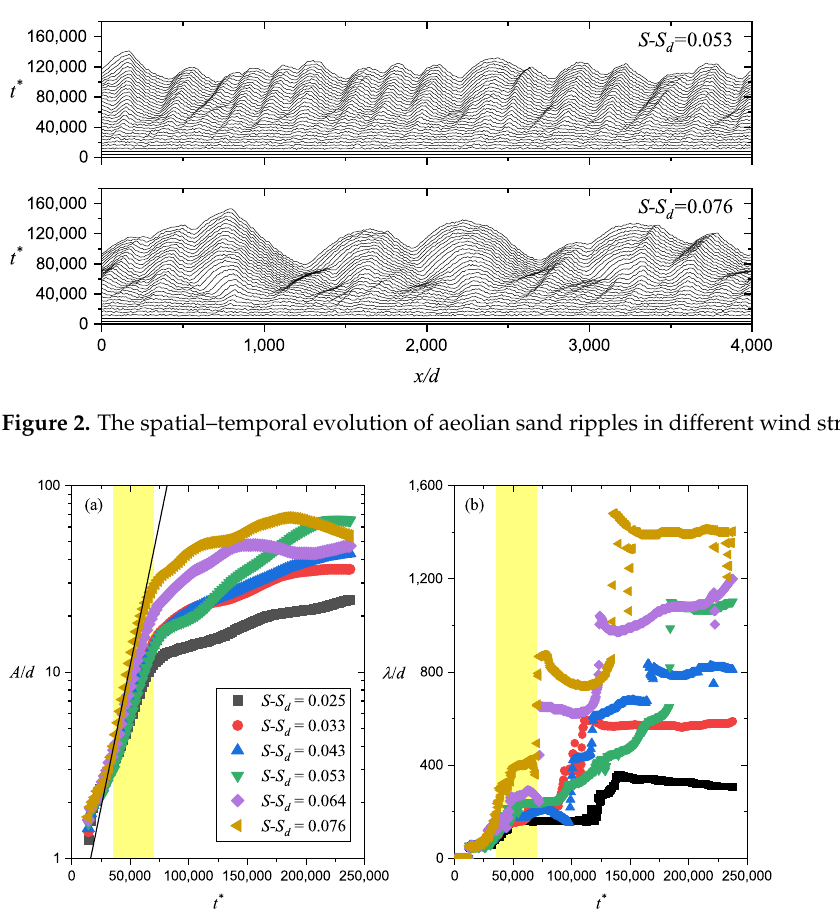
Figure 3. Sand ripple amplitude ( a ) and wavelength ( b ) increase with time. Different colors represent different wind strengths. The bright yellow shades highlight the initial stage of the ripple formation. In ( a ), for the amplitude result corresponds to S − S d = 0.076, black line is the fit line within the initial stage representing an exponential